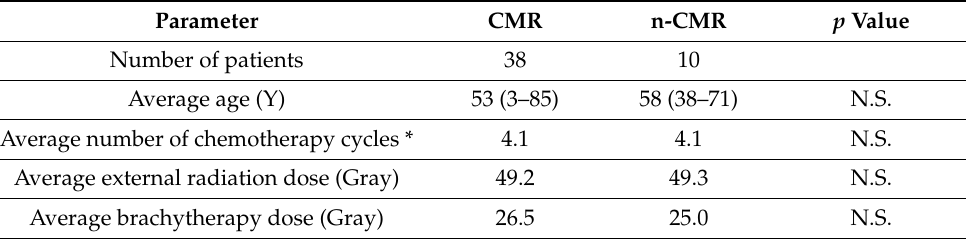
Table 3. Demographic and treatment-related data in CMR and n-CMR groups in patients FIGO stages IB2-IIB. CMR—complete metabolic response, n-CMR—noncomplete metabolic response, N.S.—Nonsignificant.